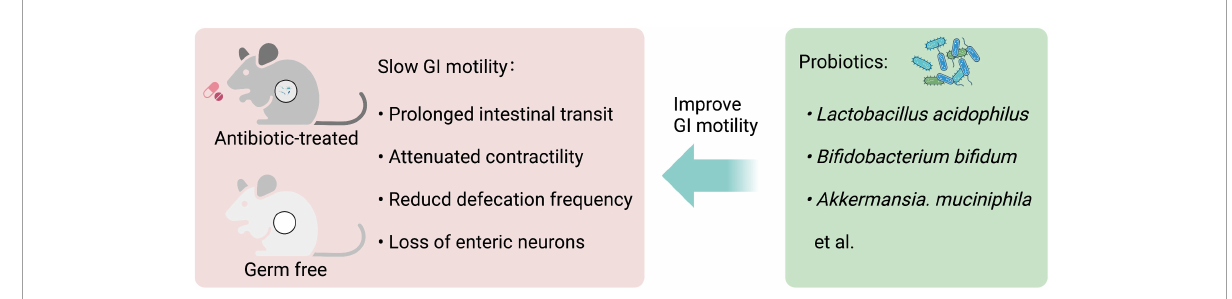
FIGURE2 Gastrointestinal (GI) motility is highly dependent on gut microbiota. Both antibiotic-treated and germ-free (GF) rodents that lack gut microbiota have slowed GI motility, with prolonged intestinal transit, attenuated contractility, reduced defecation frequency, and loss of enteric neurons. Probiotic supplements, such as Lactobacillus acidophilus , Bifidobacterium bifidum , and Akkermansia. muciniphila can improve GI